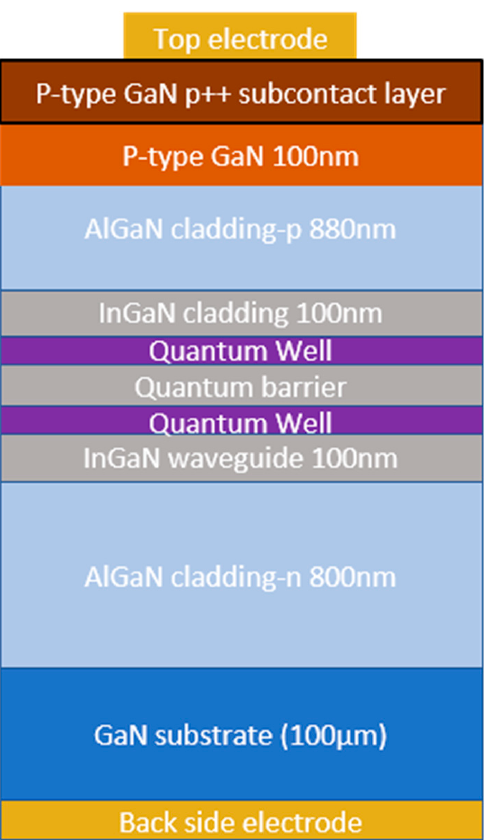
Figure 1. Schematic cross-section of the epitaxial structure of laser diodes used in the present study [20].